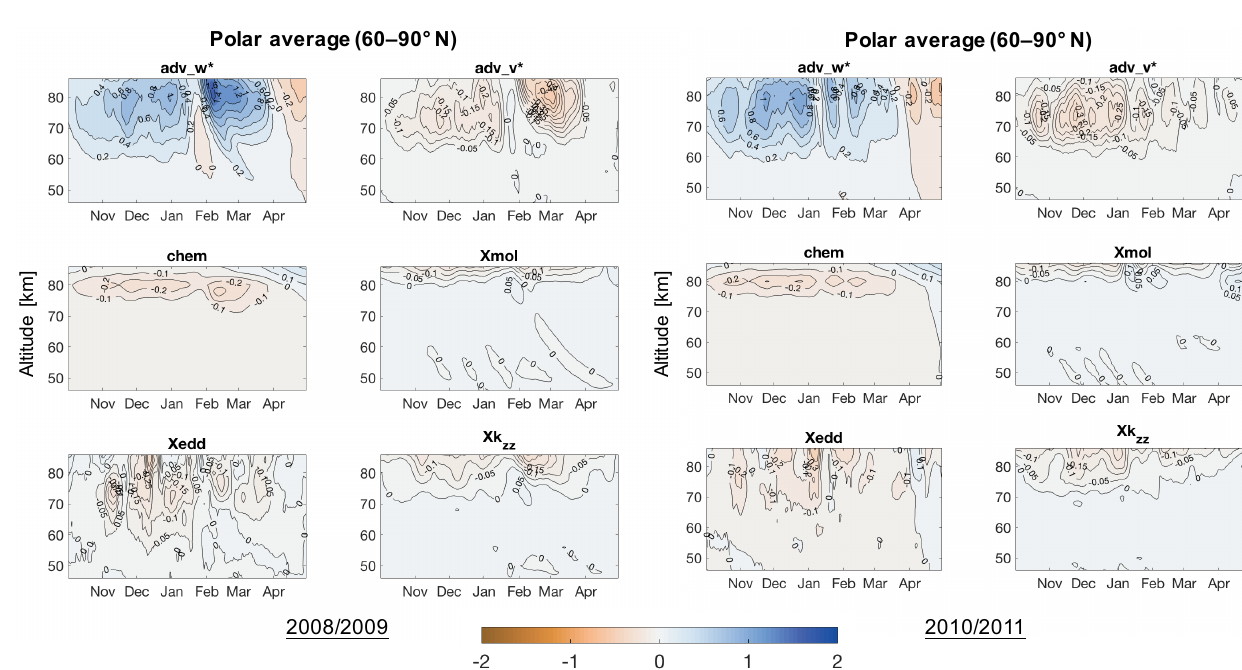
VMRs, to retrieve a vertical profile of the rates of vertical motion, as in Bailey et al. (2014). The term used here to de- note the rate of vertical motion calculated using CO VMR is w CO , following Hoffmann (2012). The second method